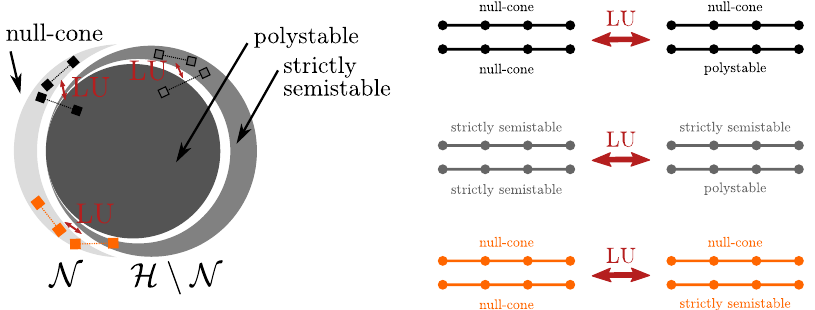
Figure 8: Illustration of how LUs operating jointly on two multipartite states may not only alter the SLOCC classes of the two considered states, but also the orbit type of the SLOCC classes. On the left we depict the Hilbert space partitioning into the three distinct orbit types: The null-cone N , strictly semistable classes, and polystable classes. On the right hand side, we depict possible orbit type changes. First, we depict two states in the null-cone which can be transformed to one state in the null-cone as well as one polystable state. Then, we depict two strictly semistable states which can be transformed to one strictly semistable states as well as one polystable state. On the bottom, we depict two states in the null-cone that can be converted to a single state in the null-cone as well as a strictly semistable state. Concrete examples for all of the depicted scenarios are given in the main text. Finally, we indicate the considered pairs of states in the schematic picture of the Hilbert space on the left-hand